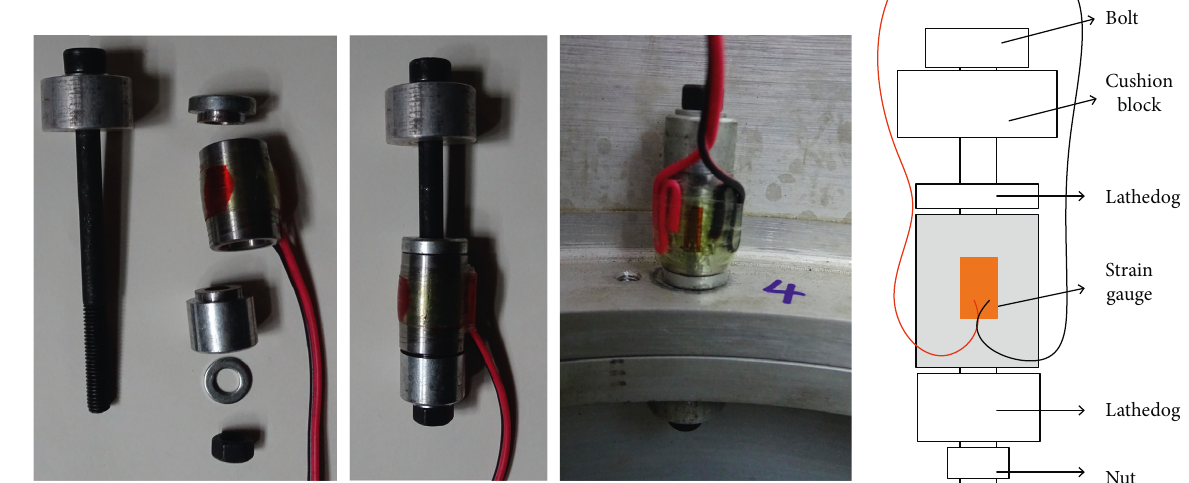
Figure 5: The signal acquisition sensor of the bolts force.